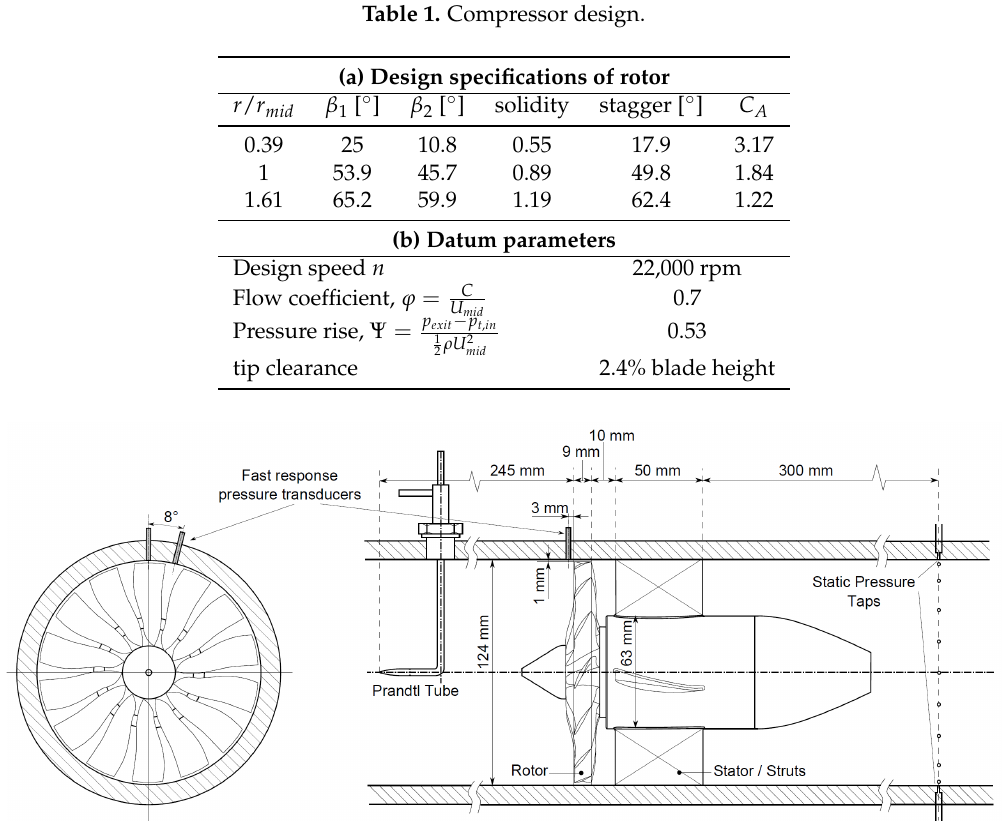
Figure 1. Measurement